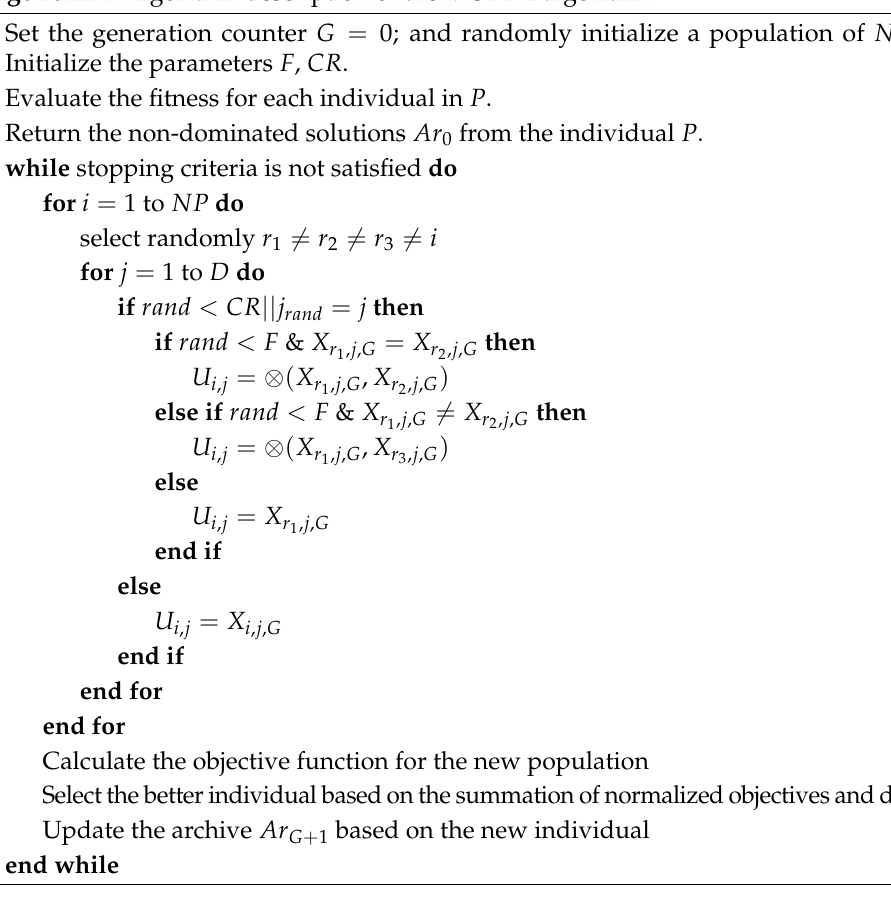
Algorithm 1 Algorithm description of the MOBDE